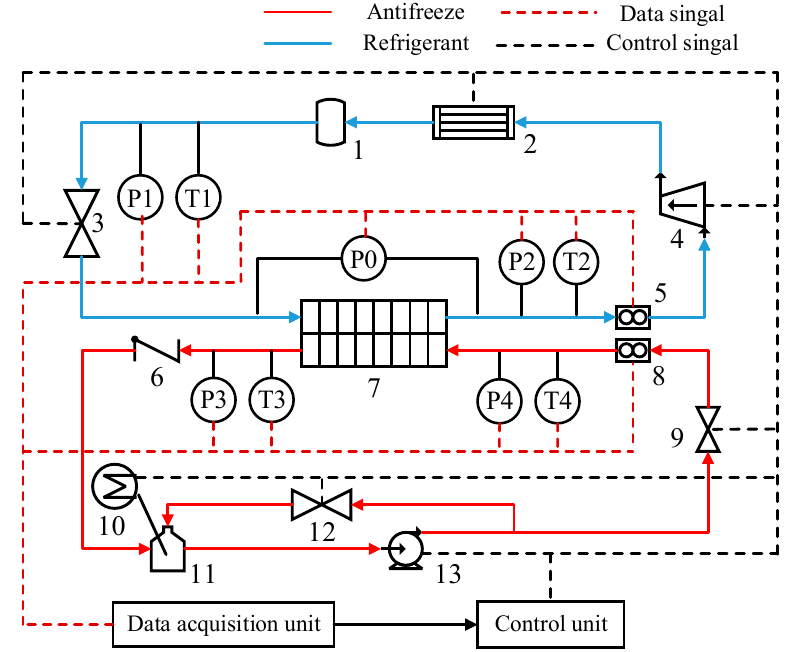
Figure 4. Schematic of the experimental facility [8], (1: condenser dryer; 2: water-cooled plate fin